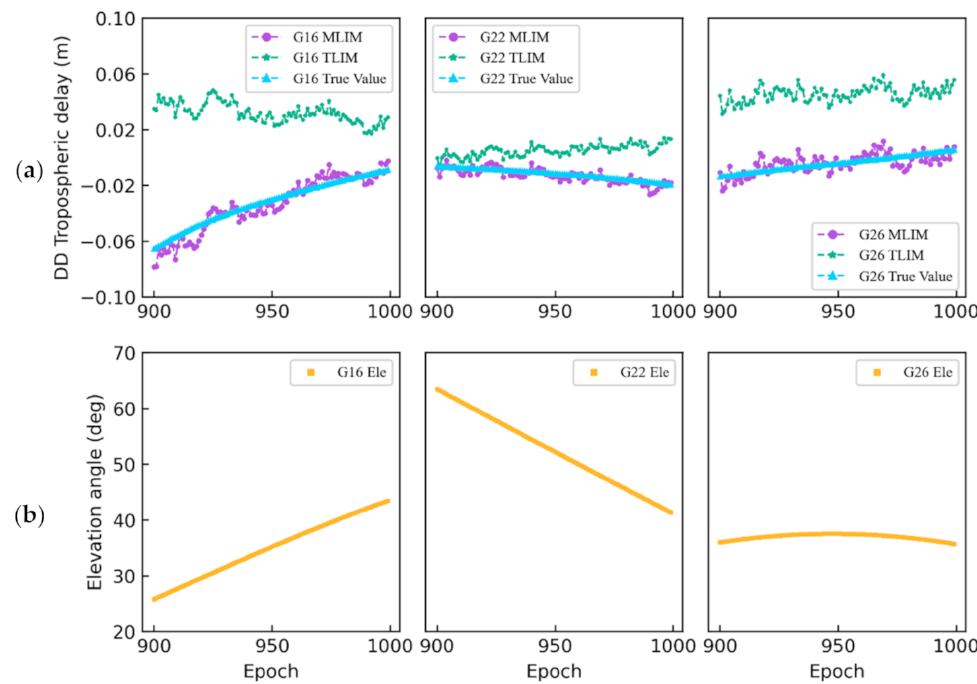
Figure 9. The DD tropospheric delay obtained by different methods ( a ) and elevation angles ( b ) for satellites G16, G22, and G26 at the rover station